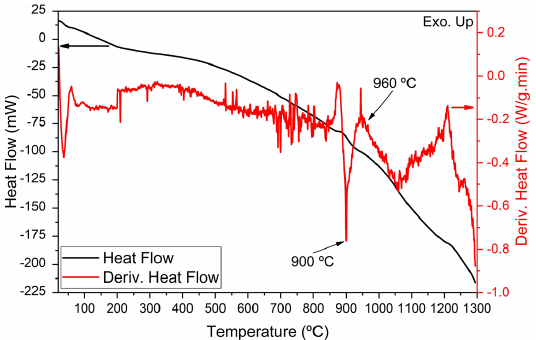
Figure 2. Differential scanning calorimetry of Ca Glass (10 ºC/min heating rate).